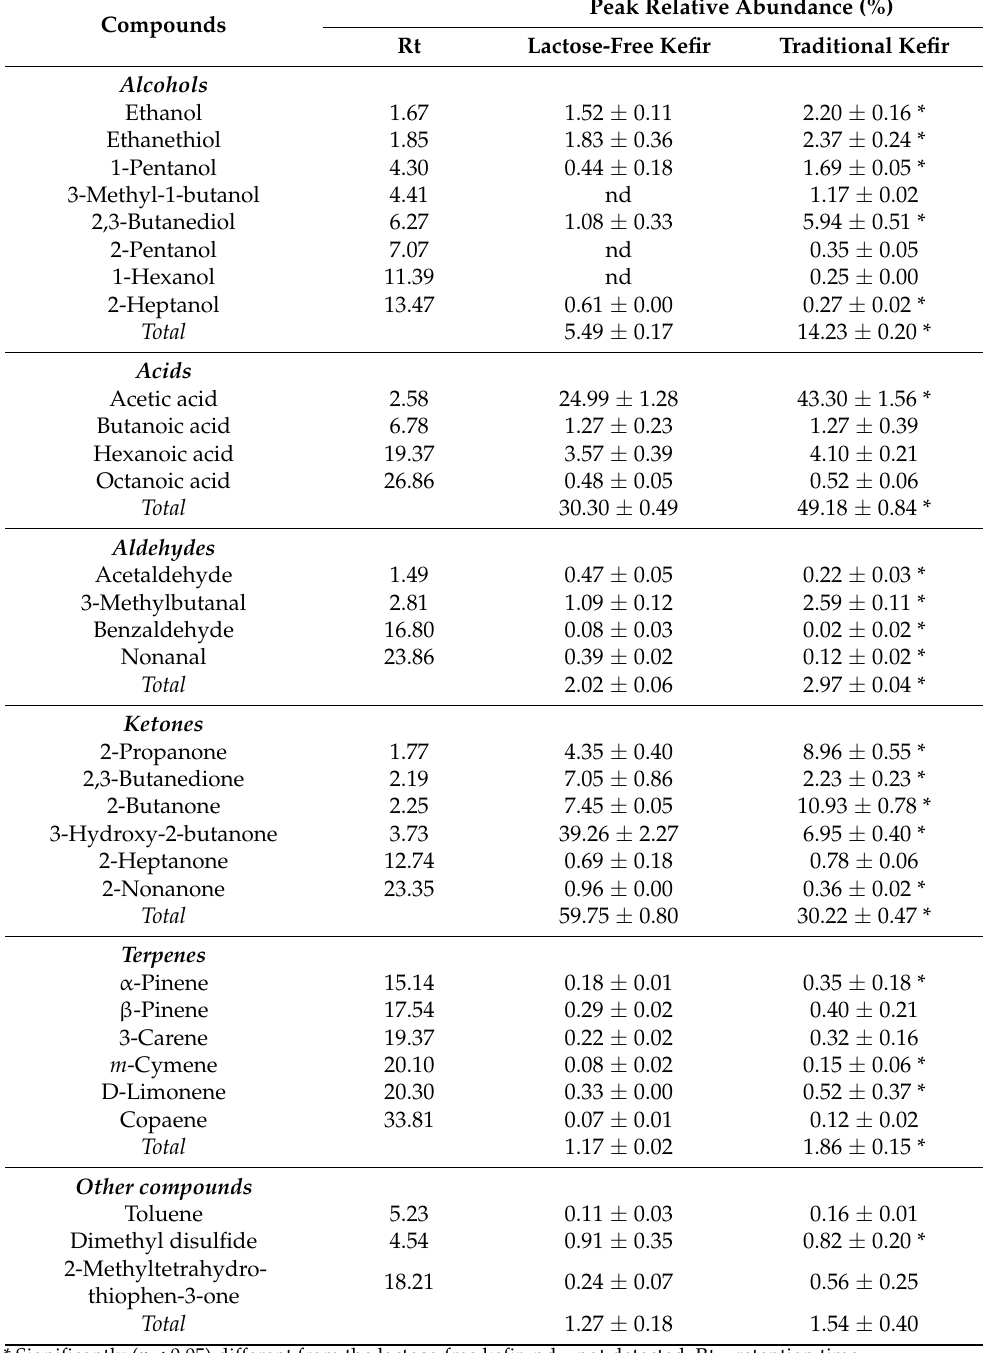
Table 2. Volatile compounds identified in kefir and their relative abundance (means ± SD, n = 9). Peak Relative Abundance (%) Compounds Rt Lactose-Free Kefir Traditional Kefir